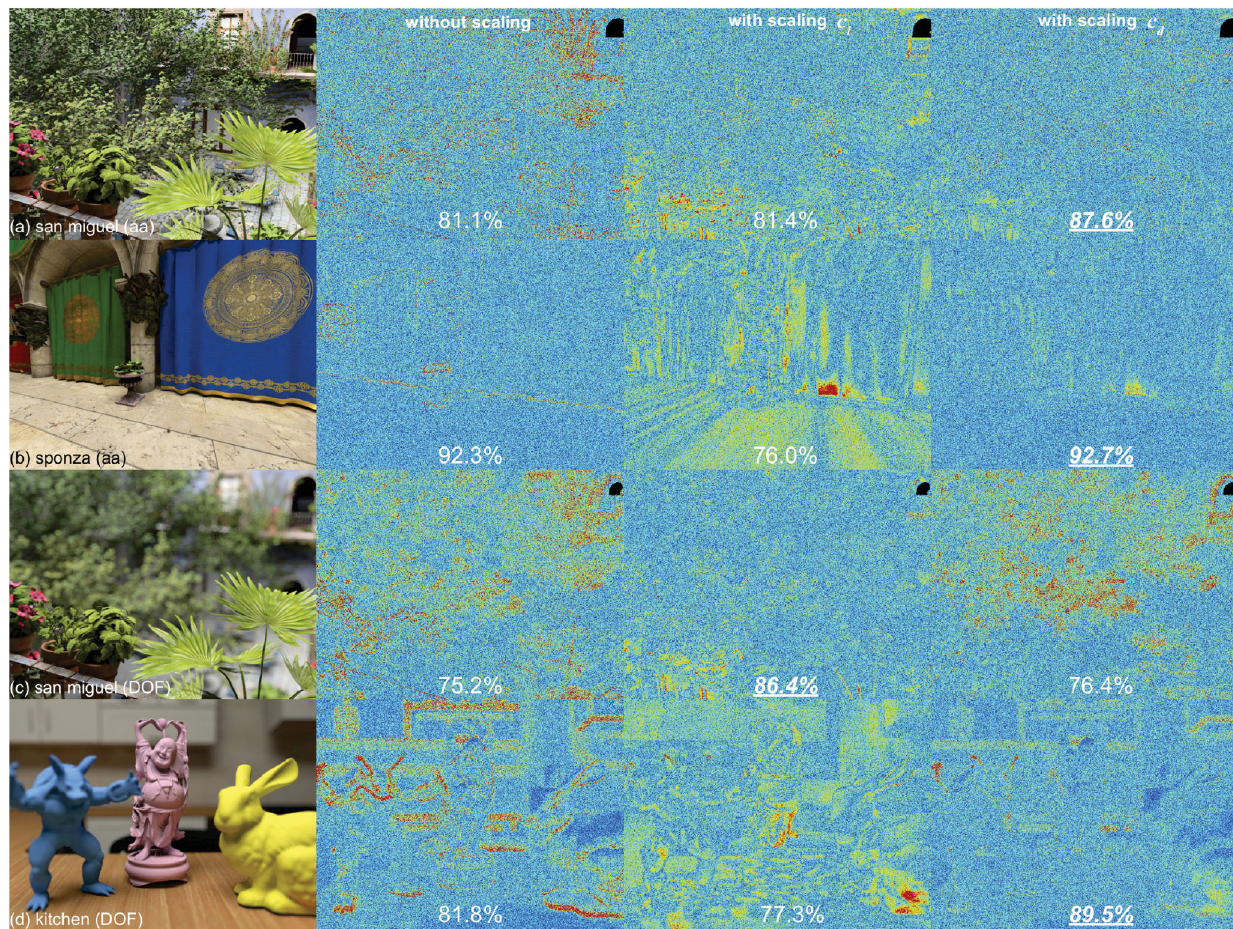
Fig. 9 Cluster selection without scaling (the second column), scaling by c l (the third column), and scaling by c d (the fourth column). The left column shows the reference solutions and the other images show the relative errors in false color. The values in each relative error image show R (cid:2) . Scaling using c d yields better estimation accuracies than not scaling or scaling by c l